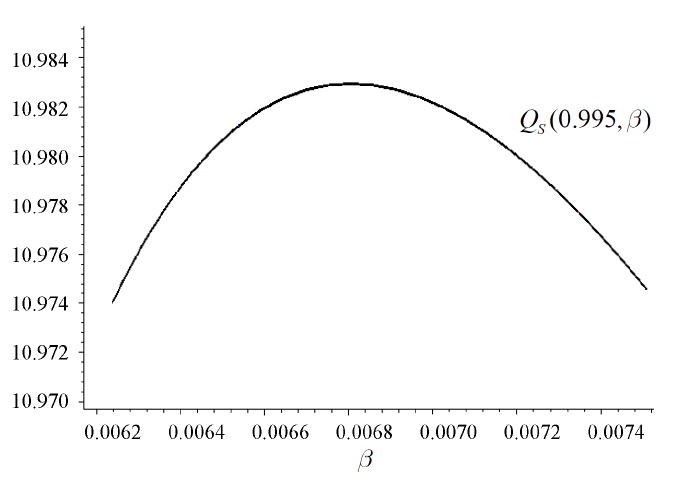
Figure 6: Plot of the parametrized quantile function Q S (0.995, β ) = F −1